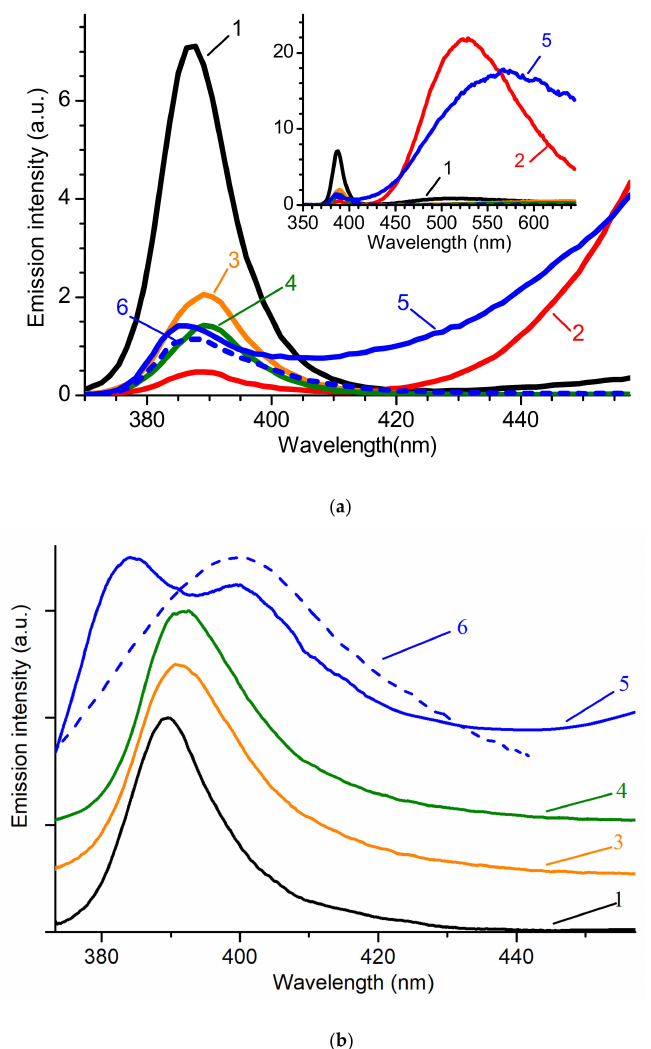
Figure 3. RT luminescence spectra of studied ZnO samples under X-ray ( a ) and photo- ( b ) excitation for: 1—whiskers; 2—whiskers after annealing in air; 3—nanowalls; 4—multipods; 5—undoped ceramics; 6—ZnO ceramics doped with 0.075 wt.% of Ga. PL spectra were normalized at maximum and vertically shifted for